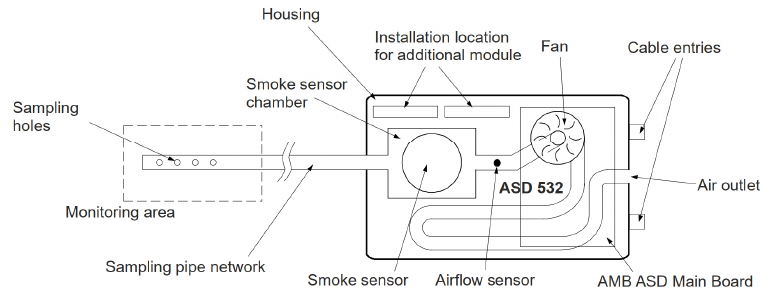
Figure 4. General operating principle of ASD.